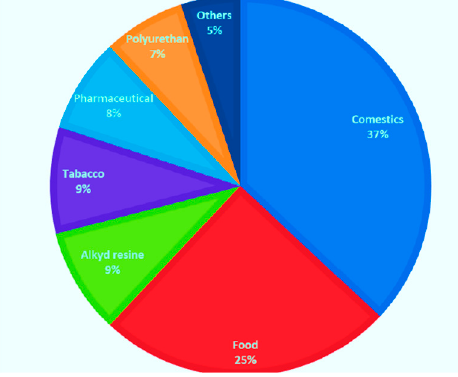
Figure 16. Crude glycerol’s most typical applications [217].